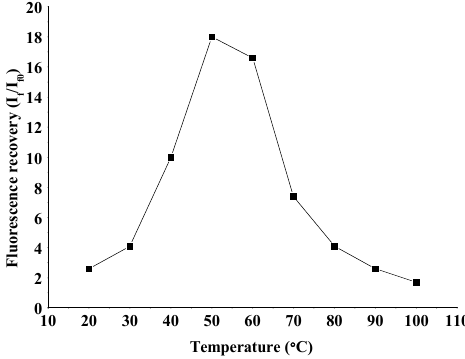
Figure 6. The influence of temperature on the fluorescence recovery of Alcian 8GX—AlS 4 Pc.